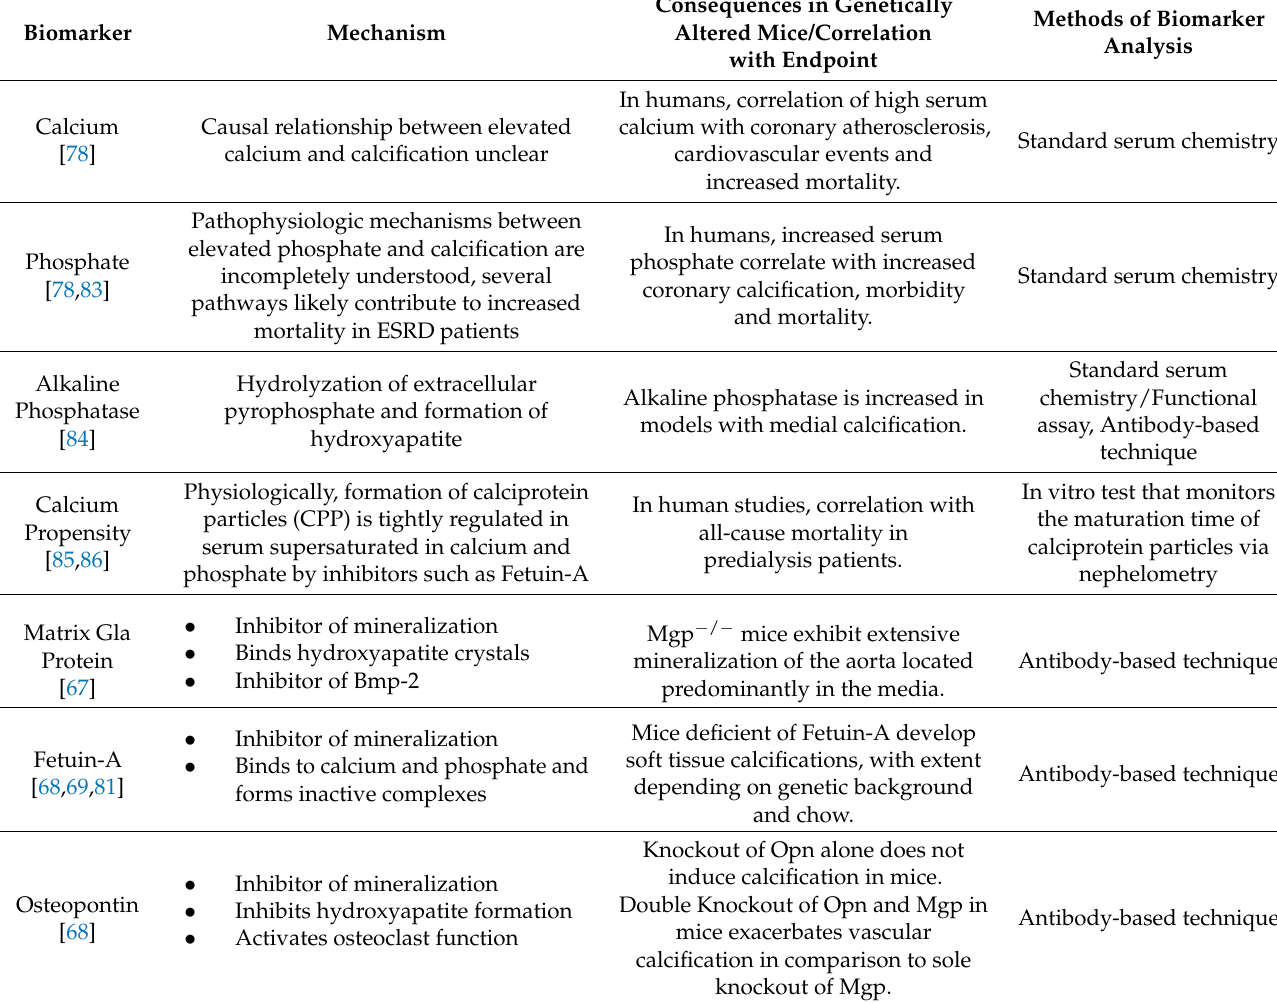
Table 3. Selected serum biomarkers for vascular calcification utilized in rodent models